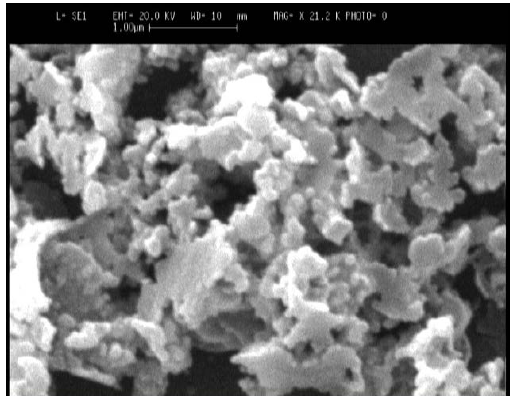
Fig. 3. The SEM image of the coupled ZnO/SnO 2 photocatalysts.